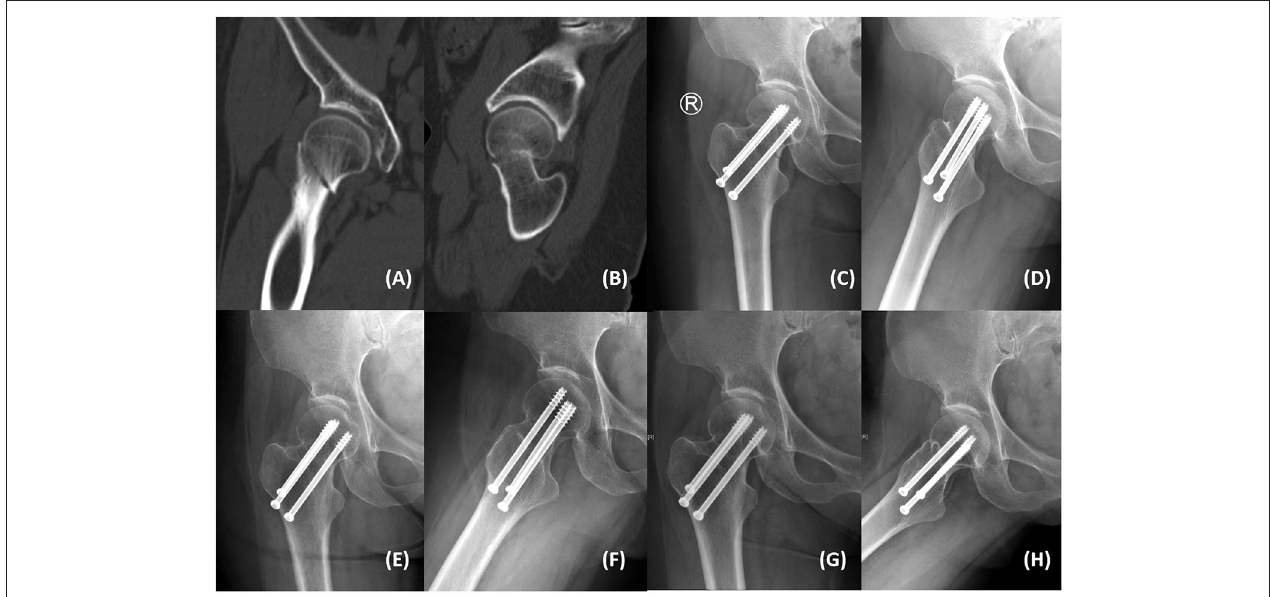
FIGURE 1 | A 59-year-old woman from the TCS group presented with right hip pain and limited mobility after a fall. (A,B) Computed tomography showed right femoral neck fracture (Garden III, Pauwels III). (C,D) Postoperative anteroposterior and lateral radiographs showed satisfactory fracture reduction with acceptable implant position. (E,F) Anteroposterior and lateral radiographs at the 3-month follow-up showed that the fracture line was blurred. (G,H) Anteroposterior and lateral radiographs at the 24-month follow-up showed that the fracture was healed without femoral head collapse and internal fixation failure. The Harris hip score was 94 without femoral neck